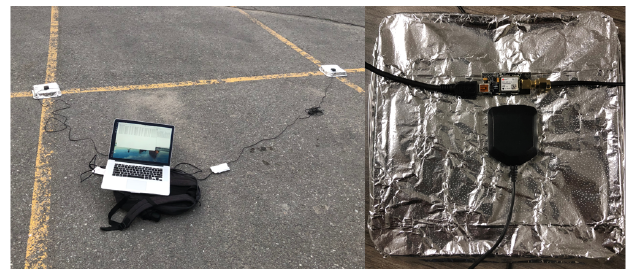
Figure 4. Experiment setup.